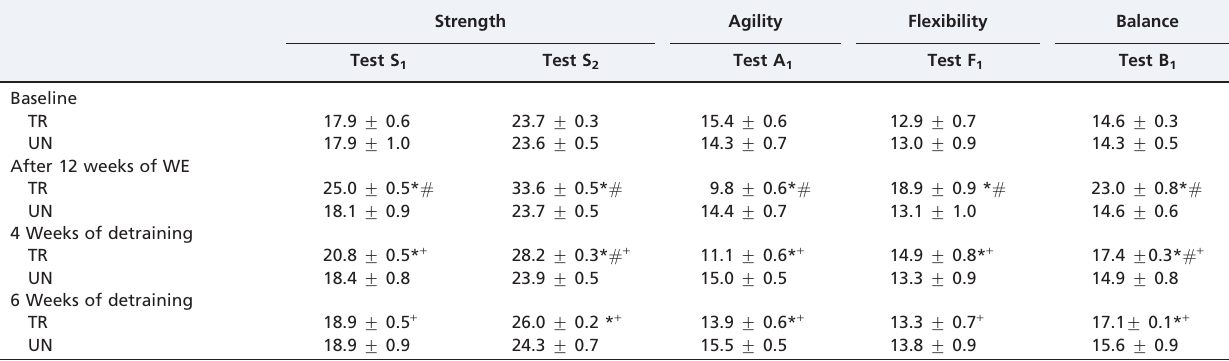
Table 2 - Changes in functional fitness after training and detraining.